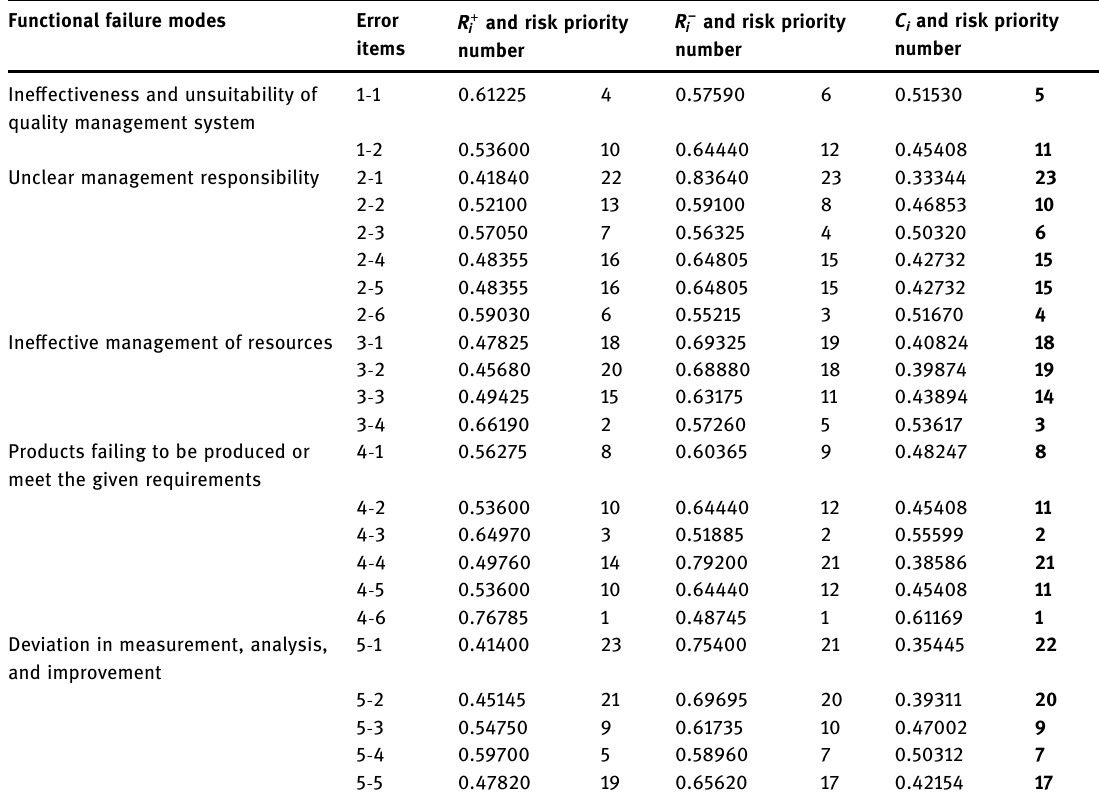
Table 2: Risk order of various quality management human errors Functional failure